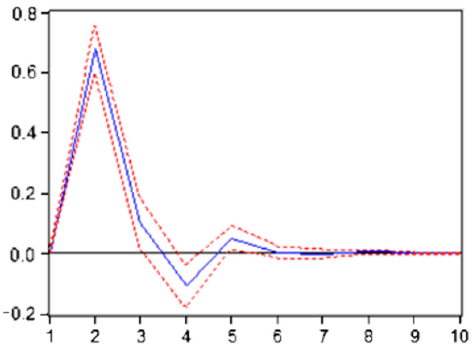
Figure 7. Impulse response of Shanghai copper to New York copper return rate.